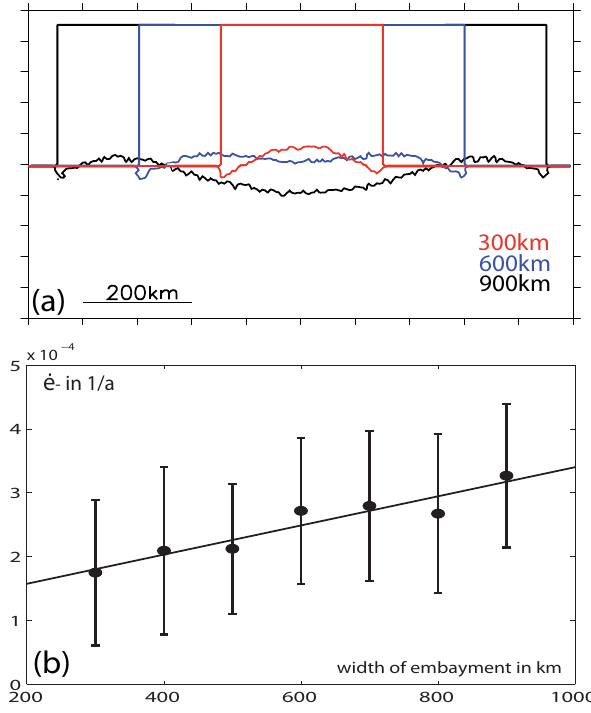
Fig. 2. Simplified set-up to investigate width dependence of sec- ond spreading-rate eigenvalue ˙ (cid:15) − . Panel a: Geometry of basin and resulting calving front for different width of the rectangular embay- ment. Panel b: Quasi-linear relation between minor spreading rate eigenvalue ˙ (cid:15) − in the center of the shelf at the calving front and the width of the